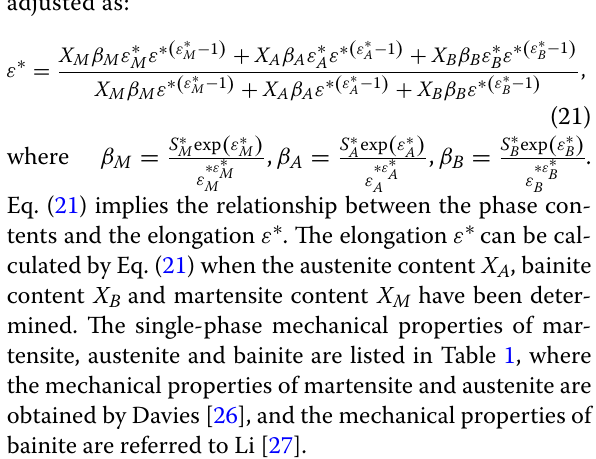
Table 1 Mechanical properties of austenite, martensite and bainite Phase Tensile strength (MPa) Elongation Austenite 640 60 Martensite